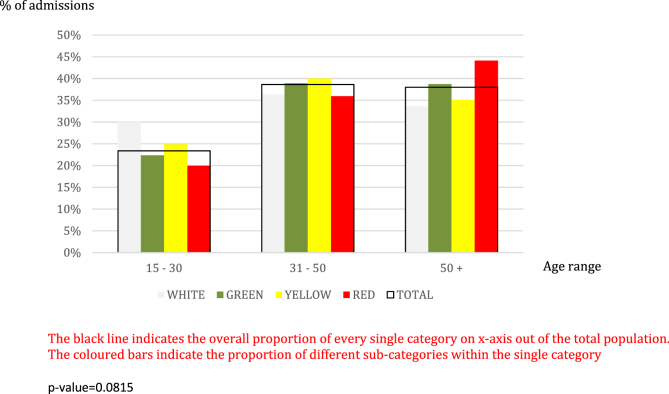
Admission codes clustered by age range.